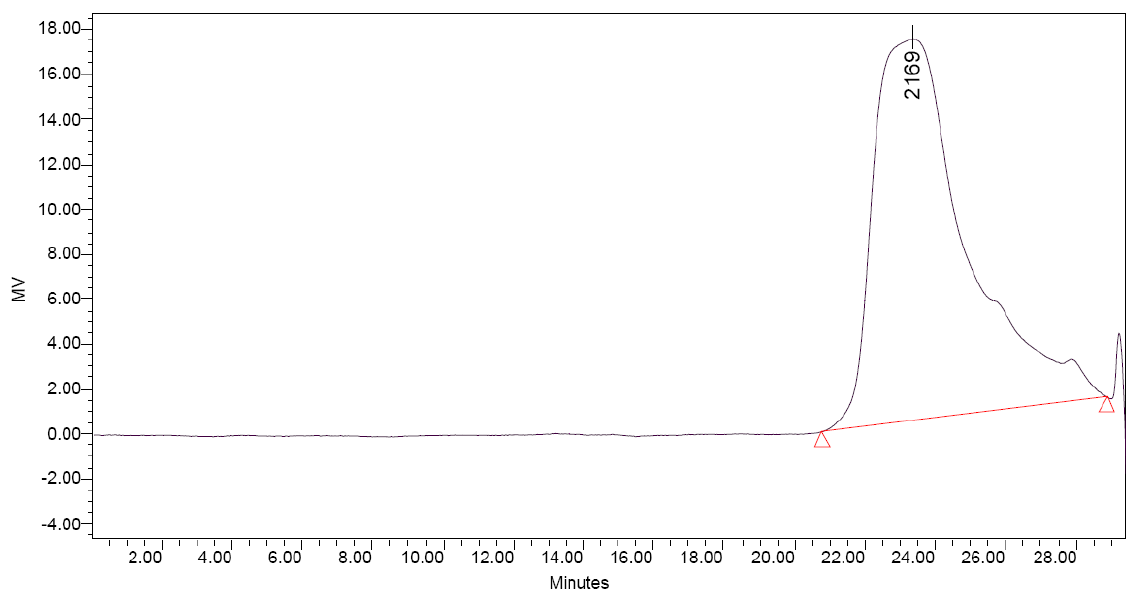
Figure 1. The GPC spectra of white solid. The solid was acidified with hydrochloric acid, triturated with excess of diethyl ether, and further purified through cryodesiccation from benzene solution to lead to a white powder, HO-PEG-COOH (2) (2.3 g, 76.6% yield, GPC: Mw=1983, Mz/Mw =1.33, see Fig. 1 and the repeating unit of ethylene oxide in the prepolymer is 45).